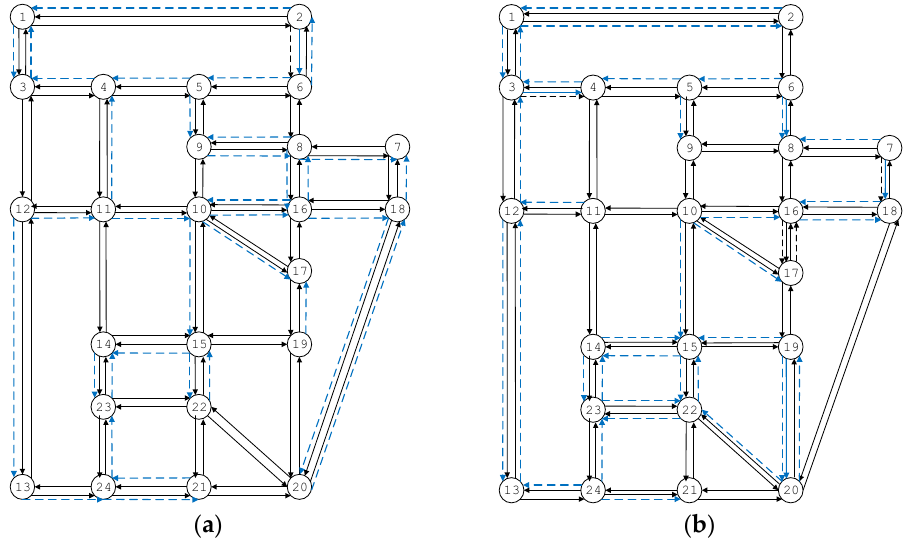
Figure 7. The optimal deployment of HOV lanes.